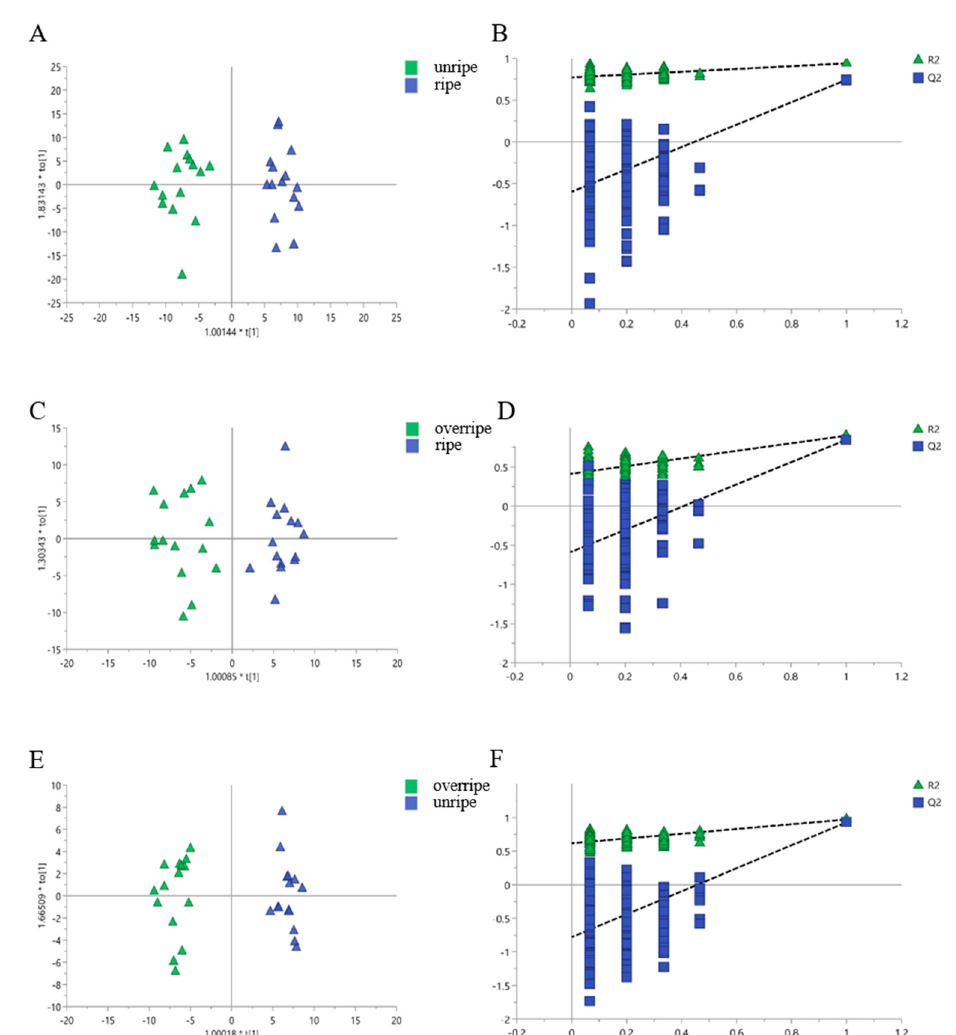
Figure 9. Results of OPLS-DA analysis of the flue-cured NTL leaves from different maturity grades. ( A ) Score plot of OPLS-DA model between unripe and ripe samples; ( B ) the permutations plot for OPLS-DA model between unripe and ripe samples, R 2 = (0.0, 0.771), Q 2 = (0.0, − 0.598); ( C ) score plot of OPLS-DA between overripe and ripe samples; ( D ) the permutations plot of OPLS-DA model between overripe and ripe samples, R 2 = (0.0, 0.411), Q 2 = (0.0, − 0.589); ( E ) score plot of OPLS-DA model between overripe and unripe samples; (F) the permutations plot of OPLS-DA model between overripe and unripe samples, R 2 = (0.0, 0.618), Q 2 = (0.0, − 0.781) of overripe and unripe samples. All blue Q 2 -values to the left are lower than the original points to the right, and the blue regression line of the Q 2 -points intersect the vertical axis below zero. This indicates that these models are not over- fitting.